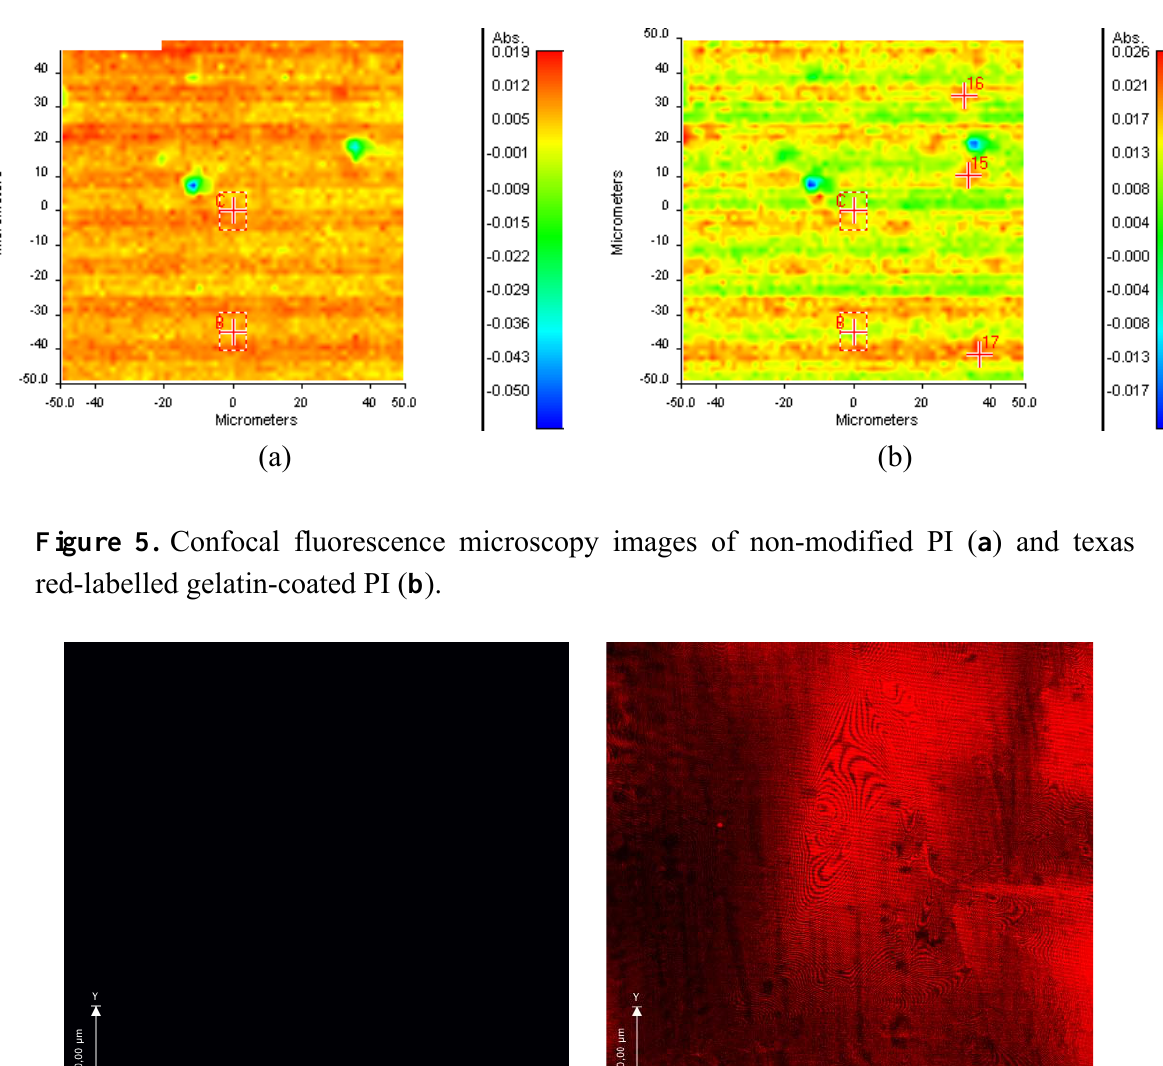
Figure 4. Attenuated Total Reflection Infrared (ATR-IR) maps showing the IR absorbance of the gelatin-coated PI at ( a ) 1,556 cm − 1 and ( b ) 1,664 cm − 1 .